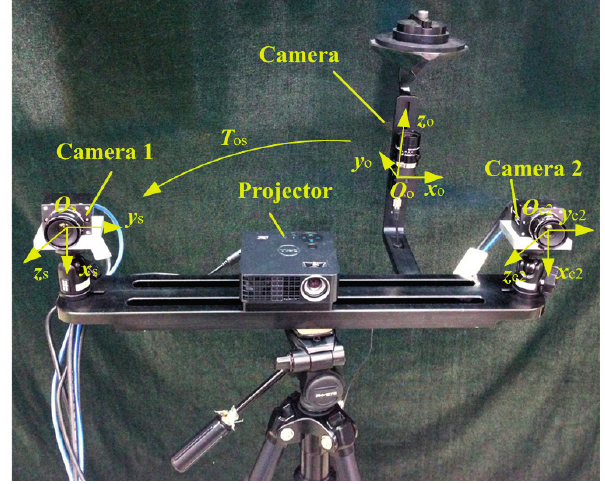
Figure 2. Structure of the 3D scanning